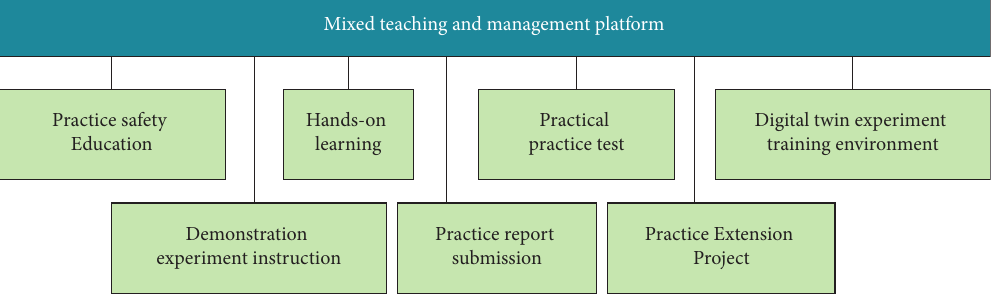
Figure 6: Modules included in the teaching platform. Table 2: Overview of the functions of the platform.